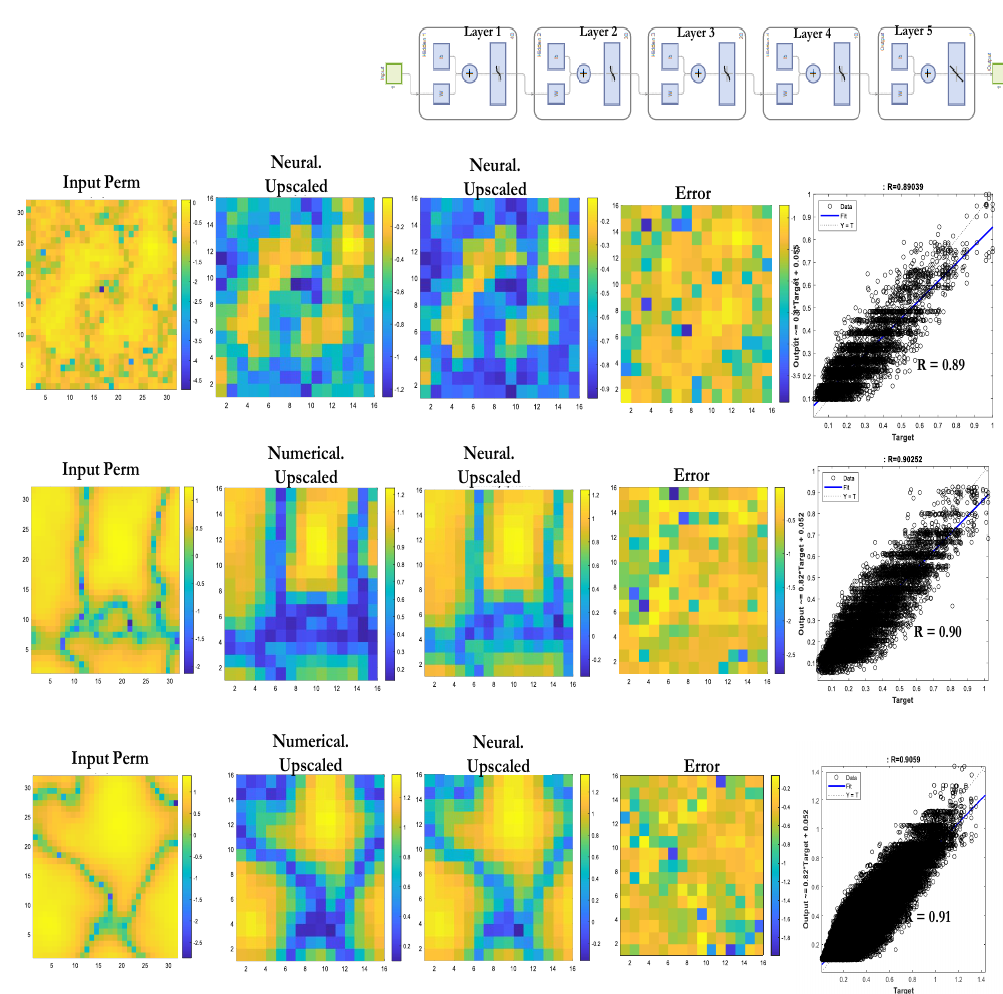
Figure 18. Figure showing sensitivity to number data set used for training and testing. Total data set is increased by a factor of 10 in 3 successive cases. As expected the regression fit improves for each case with more data values for